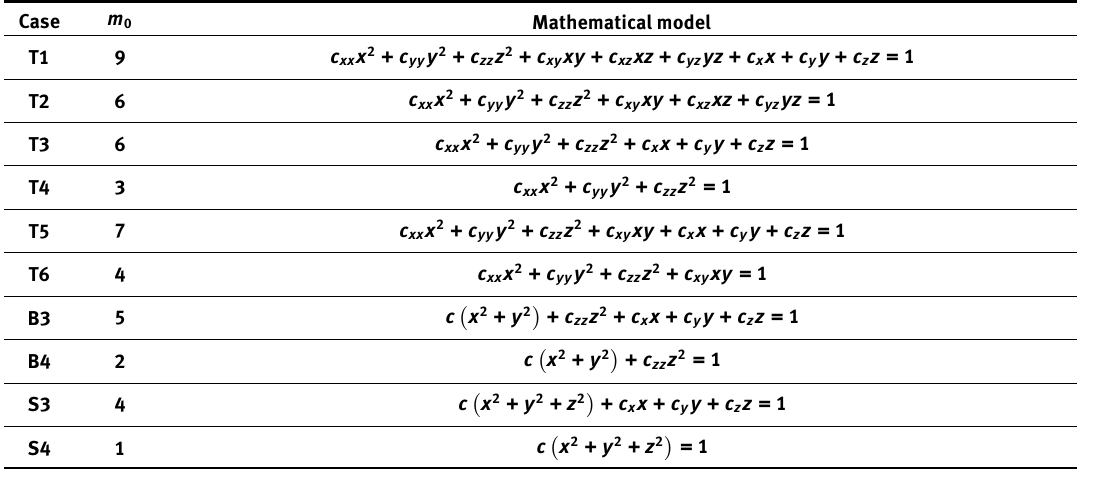
i.e. the semi-axes of the